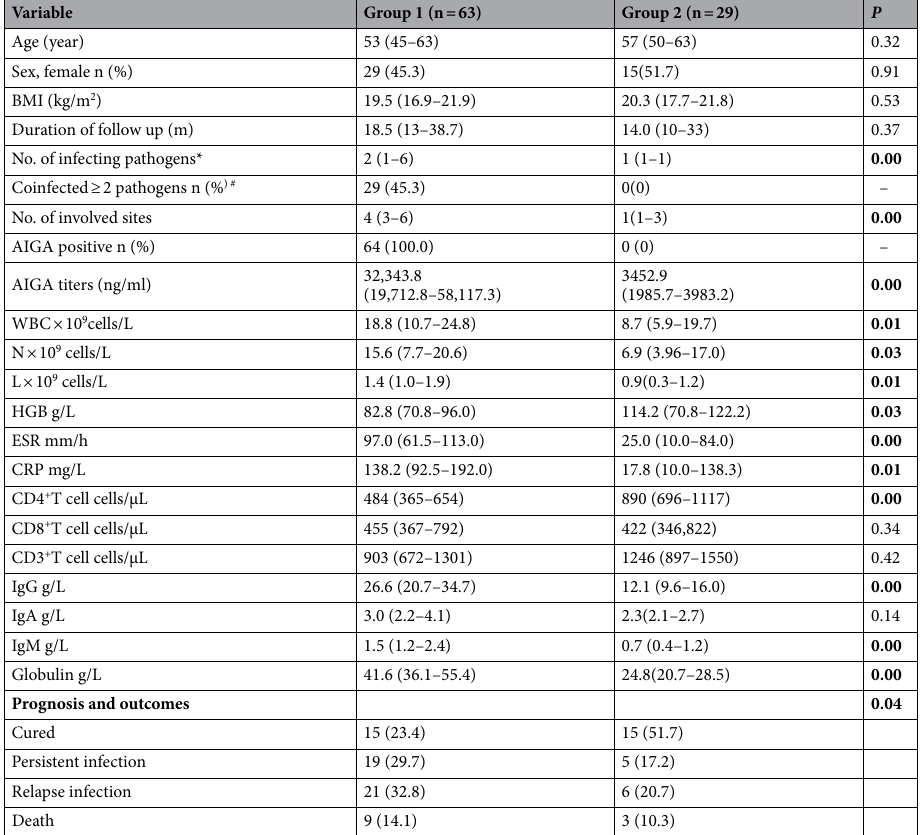
Table 1. Baseline demographics and clinical characteristics of the 92 participants. Data are expressed as median ± interquartile range. Fisher’s exact test and Kruskal–Wallis H test were used to determine statistical significance among the groups. P < 0.05. Data were collected under sterile conditions before the patient received antimicrobial therapy treatment and during the active stage of the infection. Group 1 = AIGA-positive patients, Group 2 = AIGA-negative patients. *The number of infecting pathogens is expressed as median (range minimum to maximum). # Among these, 29 patients showed co-infection or multiple infections, including 4 with TM and Salmonella co-infection, 2 with TM and Burkholderia co-infection, 2 with TM and Klebsiella pneumoniae co-infection, 1 with TM and Staphylococcus aureus co-infection, and 20 with TM and NTM co-infection. Among the 20 patients with TM and NTM co-infection, 13 were infected with more than three pathogens . Among these 13 patients, besides TM and NTM, 2 patients were infected with Staphylococcus aureus , 3 with Aspergillus , 3 with Salmonella , 3 with Burkholde ria, 1 with Candida albicans , 1 with Klebsiella pneumoniae , 1 with Providencia rettgeri , 1 with Citrobacter , and 1 with Epstein-Barr virus. BMI body